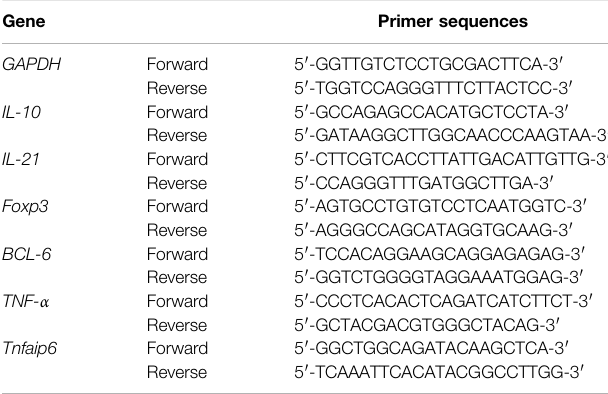
TABLE 1 | List of genes screened by quantitative real-time PCR genes assessed using SYBR Green. Gene Primer